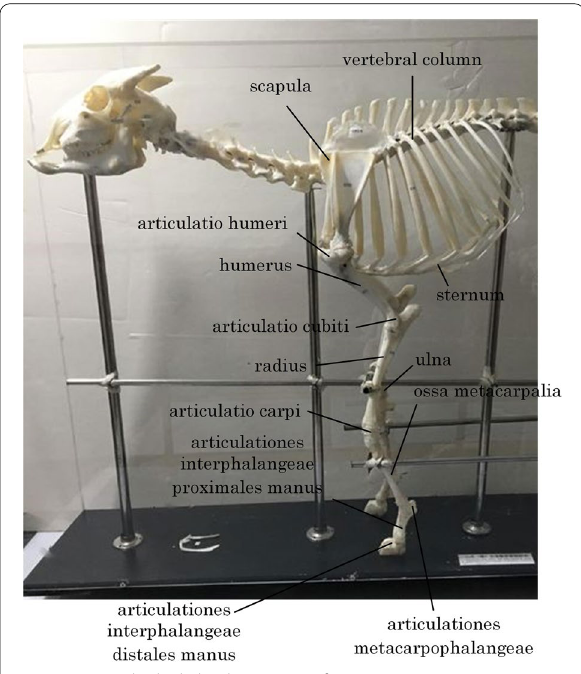
Figure 1 Forelimb skeletal structure of a ruminant